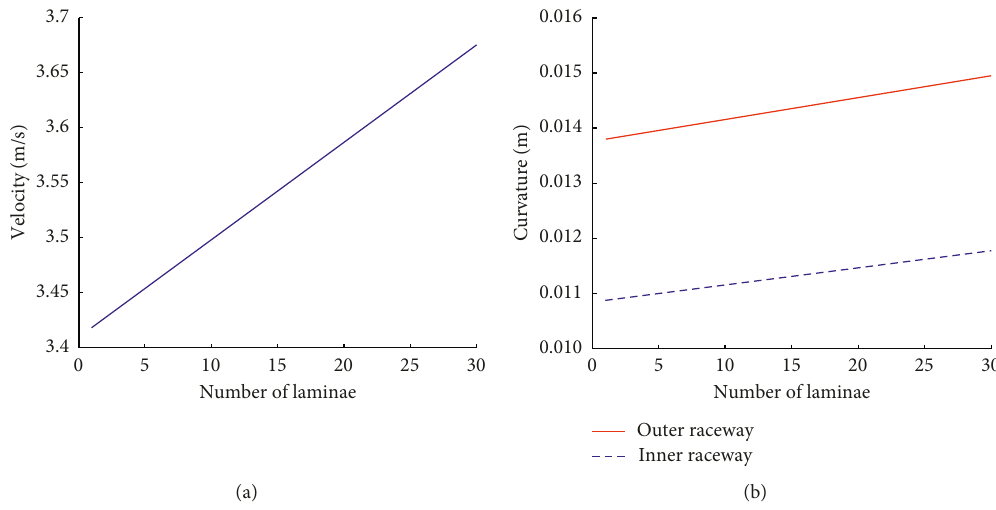
Figure 8: Contact parameters of bearings: (a) speed and (b) integrated curvature of contact pair.